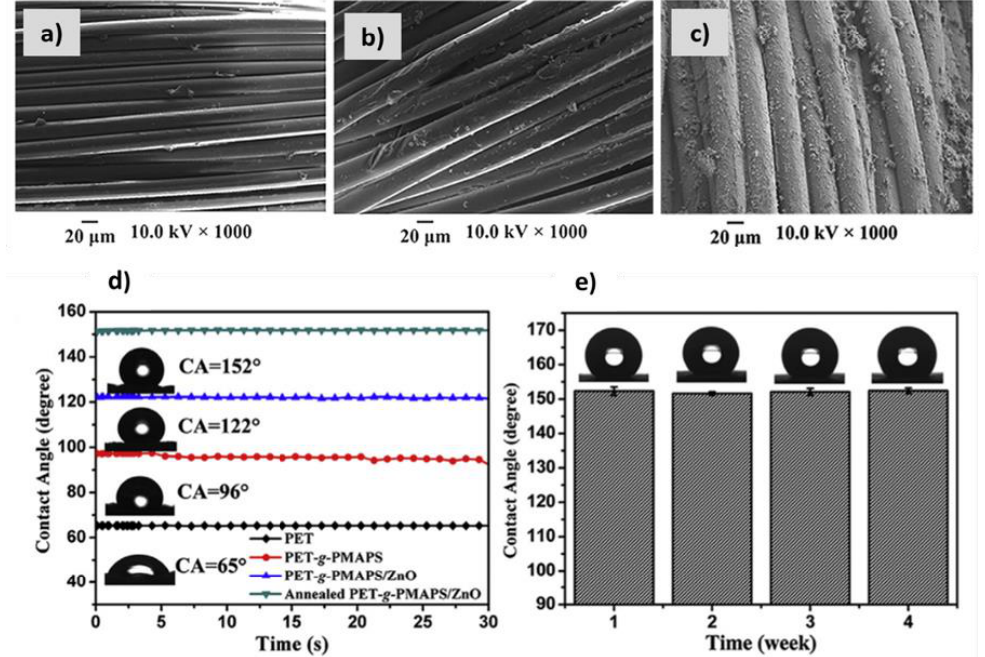
Figure 11. Surface morphology of pristine ( a ), polysilixane coated ( b ) and polysiloxane-ZnO coated ( c ) polyester fibres; water contact angles ( d ) of pristine polyester (PET), polysilixane coated polyester